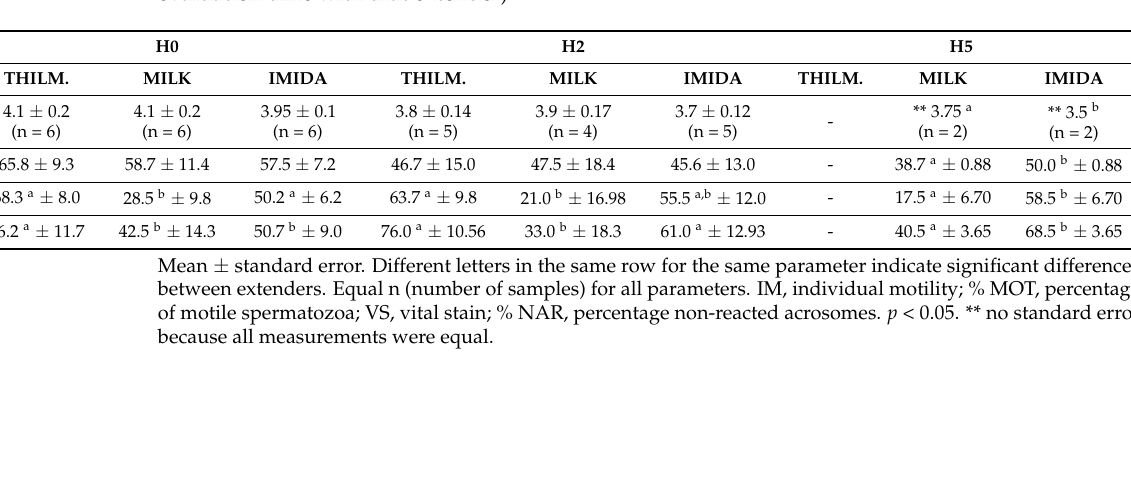
Table 12. Average semen quality parameters by subjective microscopic evaluation for male 3 in endurance test, according to extender (if there is no number: no motile spermatozoa reached that evaluation time with that